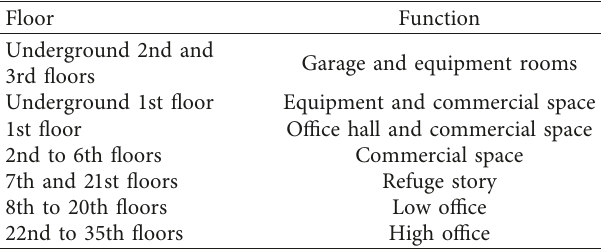
Table 1: Summary of the super high-rise building functions.